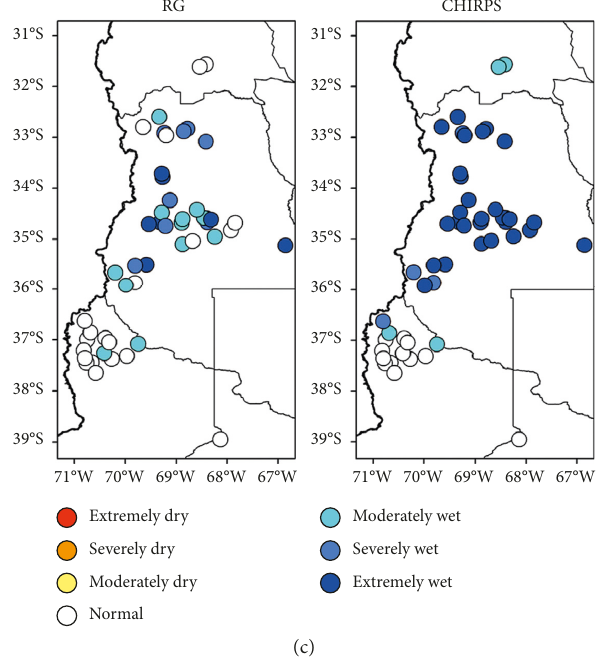
Figure 13: Spatial distribution of the SPI categories for timescales of (a) 1 month, (b) 3 months, and (c) 6 months during April 2016 considering rain gauges (RG) and CHIRPS